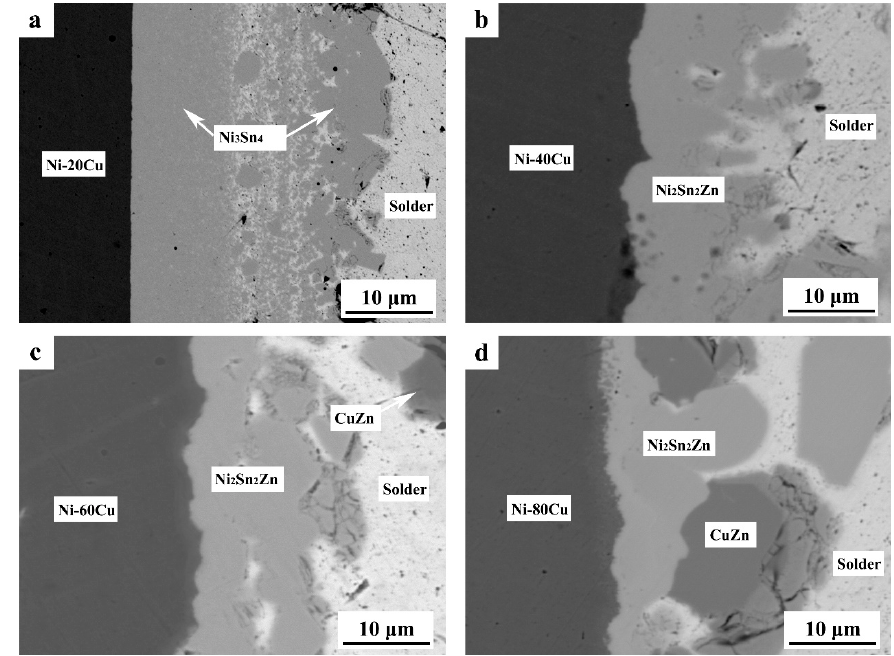
Figure 8. Cross-section micrograph of joints after soldered 60 min at 350 °C: ( a ) Sn-Zn/Ni-20Cu; ( b ) Sn-Zn/Ni-40Cu; ( c ) Sn-Zn/Ni-60Cu; ( d ) Sn-Zn/Ni-80Cu.